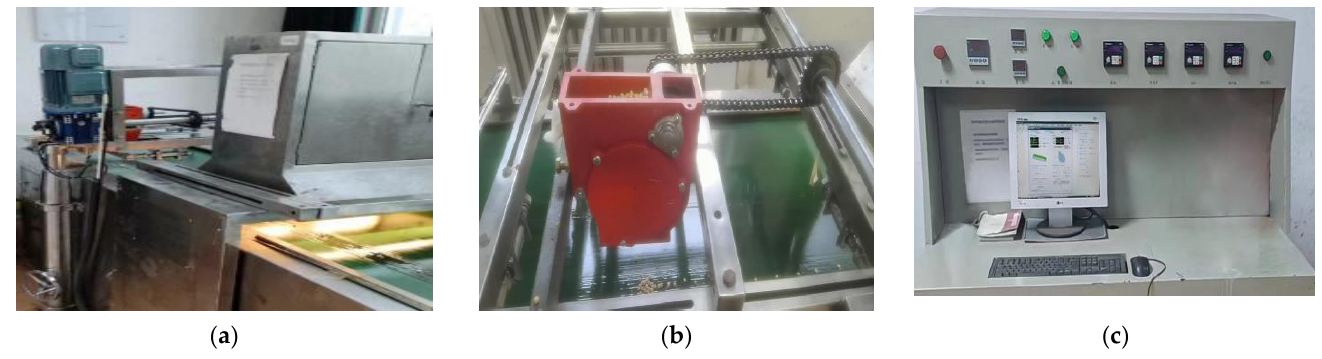
Figure 7. Seeding image monitor platform (SIMP). ( a ) Camera-monitoring platform; ( b ) seed metering speed control bracket; ( c ) image-monitoring interface.